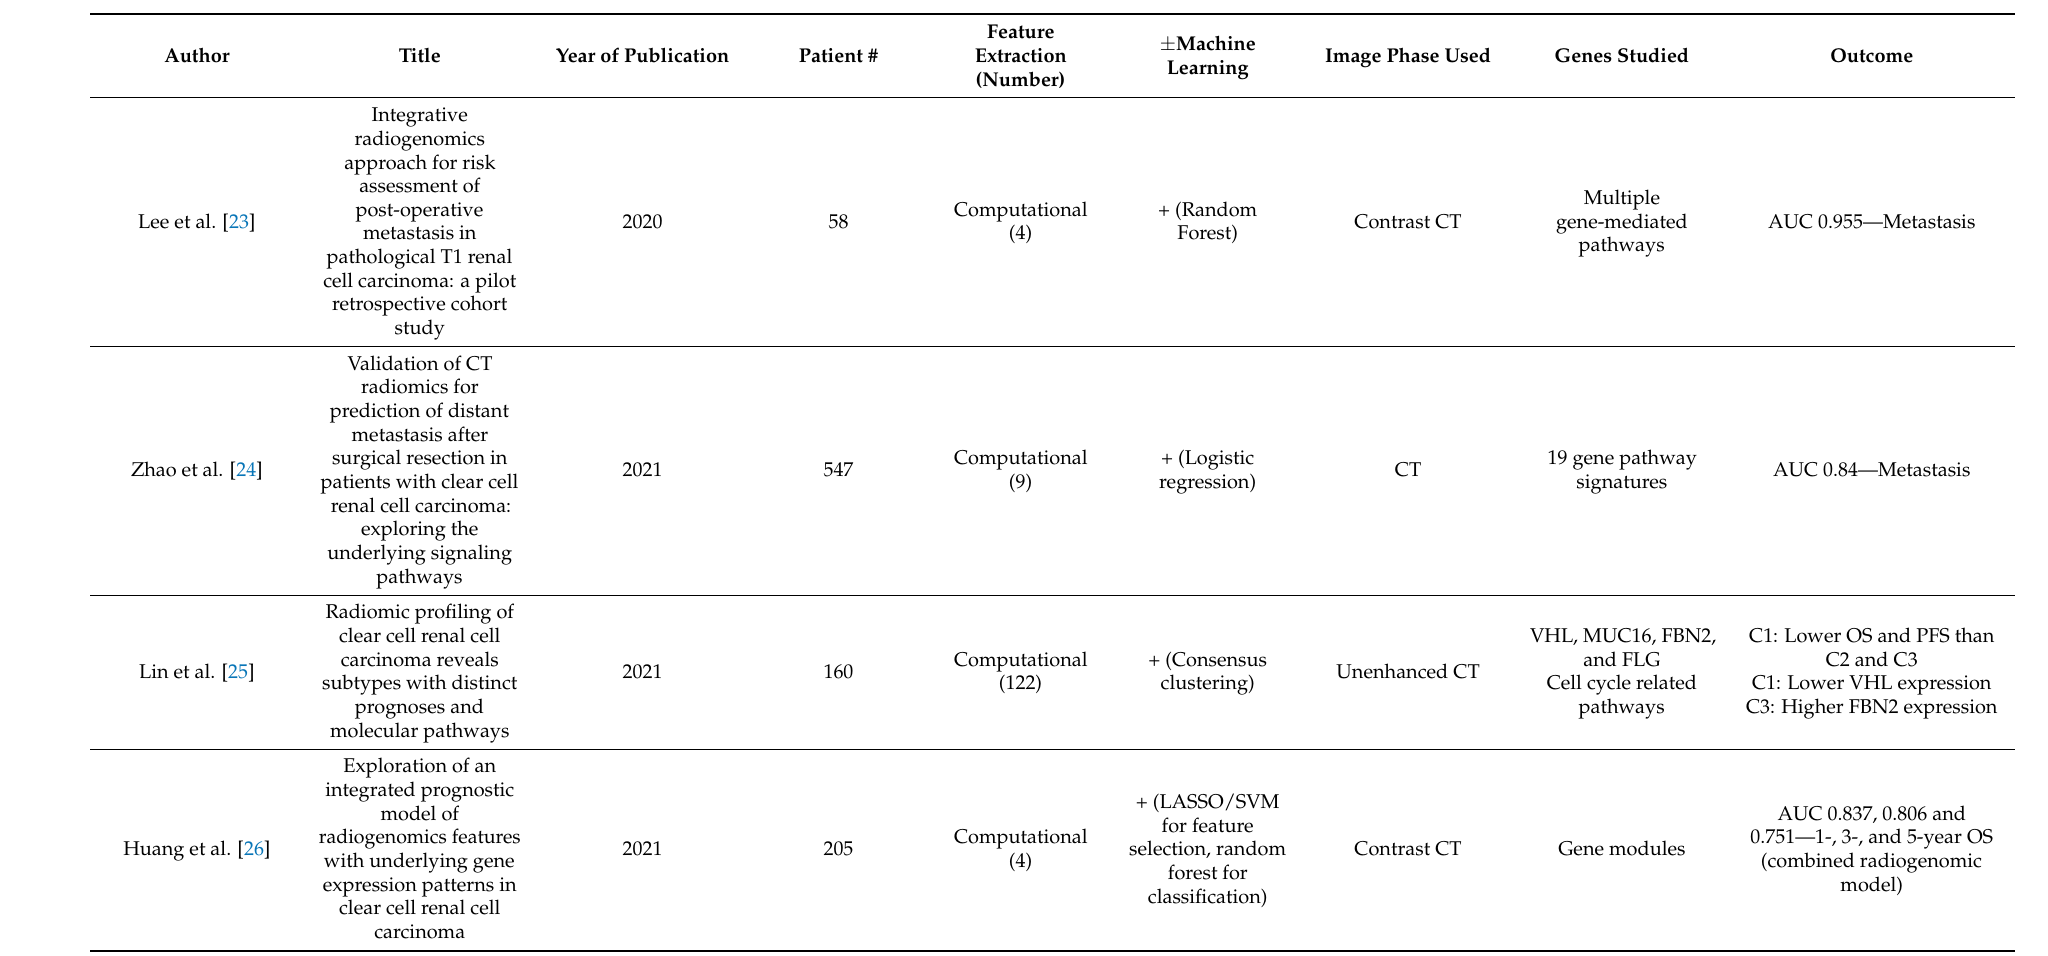
C1: Lower VHL expression C3: Higher FBN2